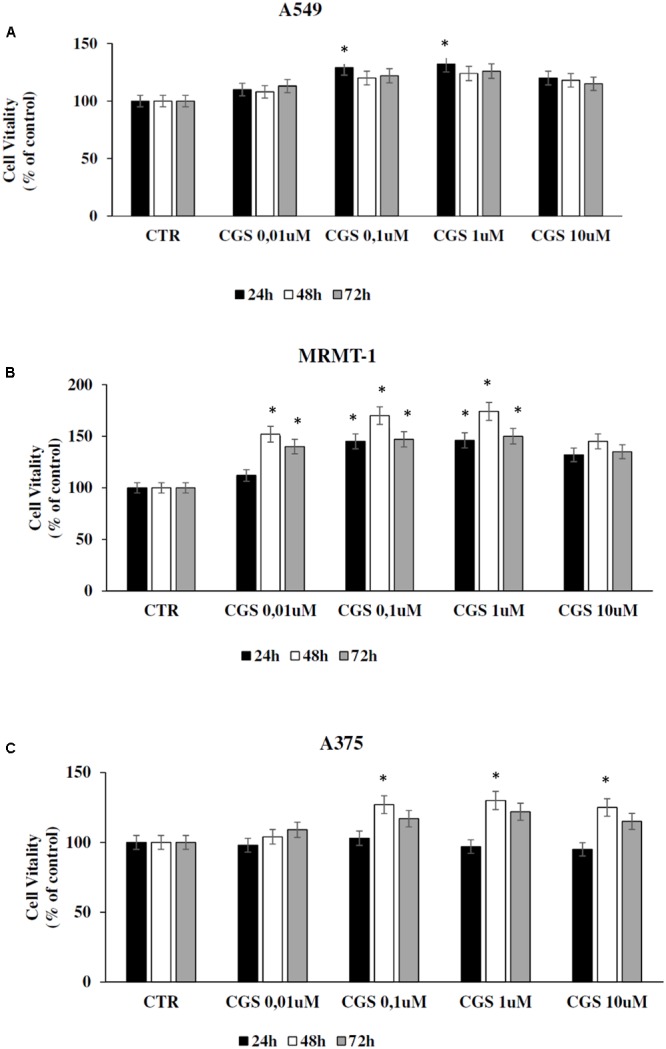
Effect of CGS 21680 on cell proliferation in A549 (A), MRMT-1 (B), and A375 (C) cell lines. Cells were incubated in the presence of 0.01–10 μM CGS 21680 for 24, 48, and 72 h and cell proliferation was evaluated by DELFIA Cell Proliferation Kit. Solutions were made up in DMSO and then diluted in cell culture medium (0.1 max 0.2% of DMSO). An equal amount of DMSO was used in control cells (CTR). ∗P < 0.01 compared with CTR. Means ± SE values from four experiments are shown. Analysis was by one way ANOVA, followed by Dunnett’s test.